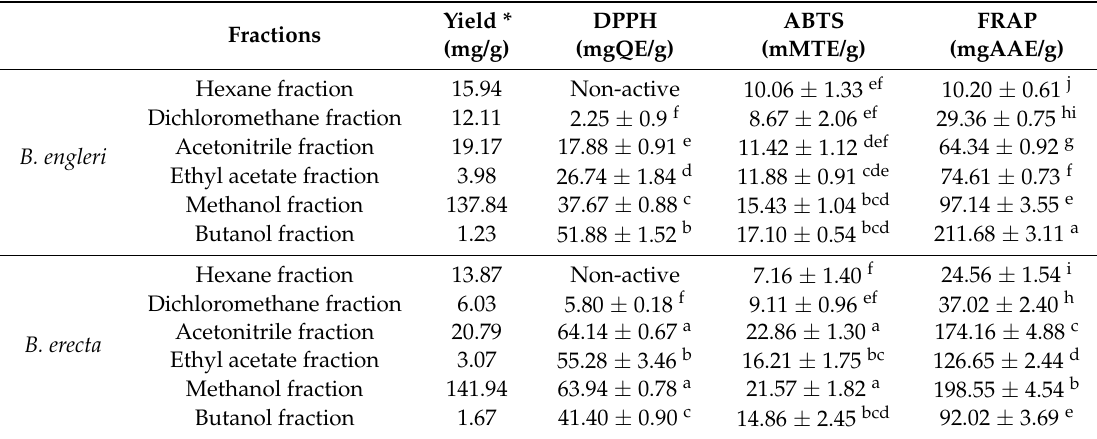
Table 1. Yield and antioxidant activity of